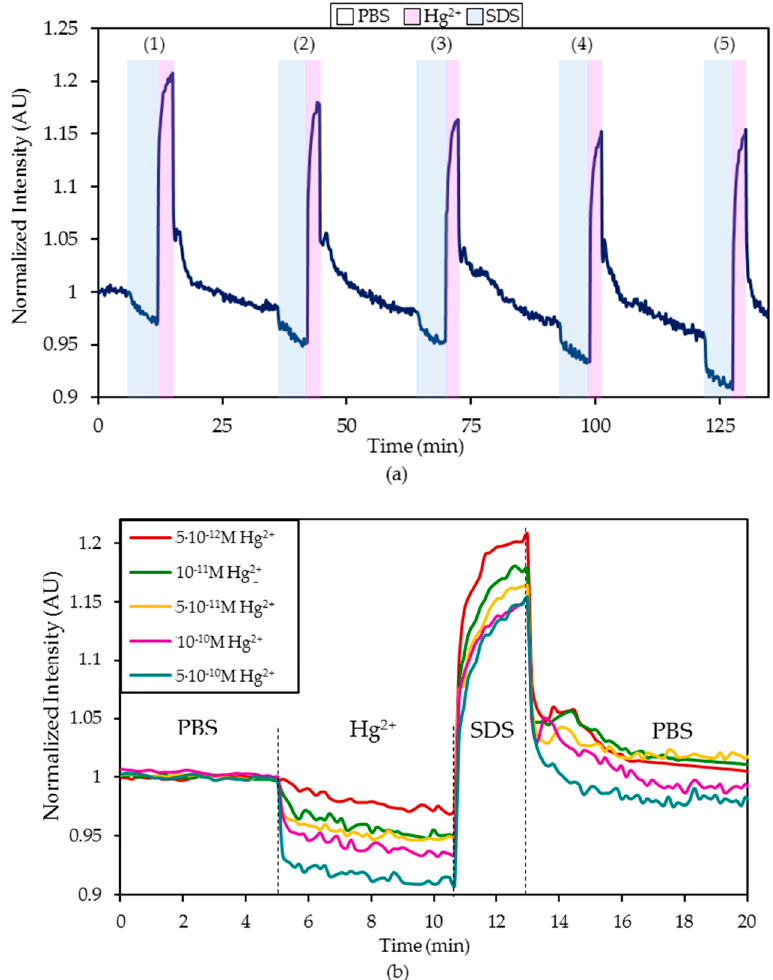
Figure 7. ( a ) Dynamic variation of the normalized luminescence intensity after 5 min exposure to different Hg 2+ concentrations ((1) 5 × 10 − 12 M, (2) 10 − 11 M, (3) 5 × 10 − 11 M, (4) 10 − 10 M, (5) 5 × 10 − 10 M,